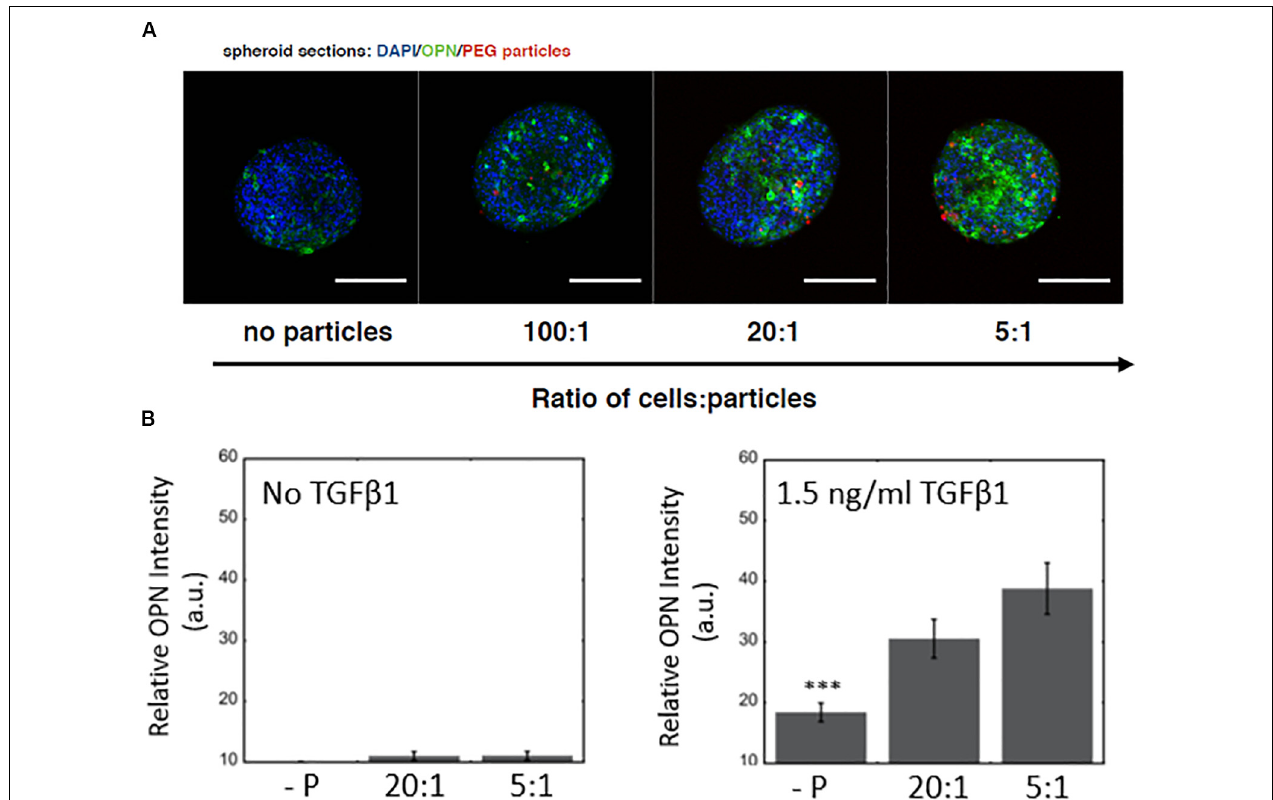
FIGURE 4 | Microparticle integration at a constant TGF β 1 dose and differentiation response for spheroids embedded with PEG hydrogel microparticles (A) Increased OPN expression with an increase in PEG microparticle concentration. No particle controls (-P). Scale bars: 150 µ m. (B) Without TGF β 1, increasing microparticle density does not have any significant effect on OPN expression, while at a constant TGF β 1 concentration (1.5 ng/ml), there is a difference between spheroids with and without